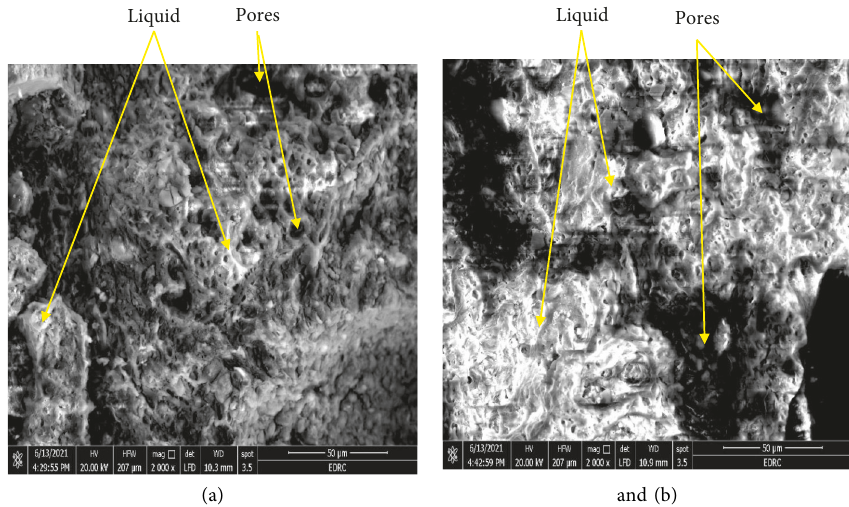
Figure 11: Sem micrographs for specimens fired at 1000 ° C containing (a) 20% GBFS and (b) 30% GBFS.